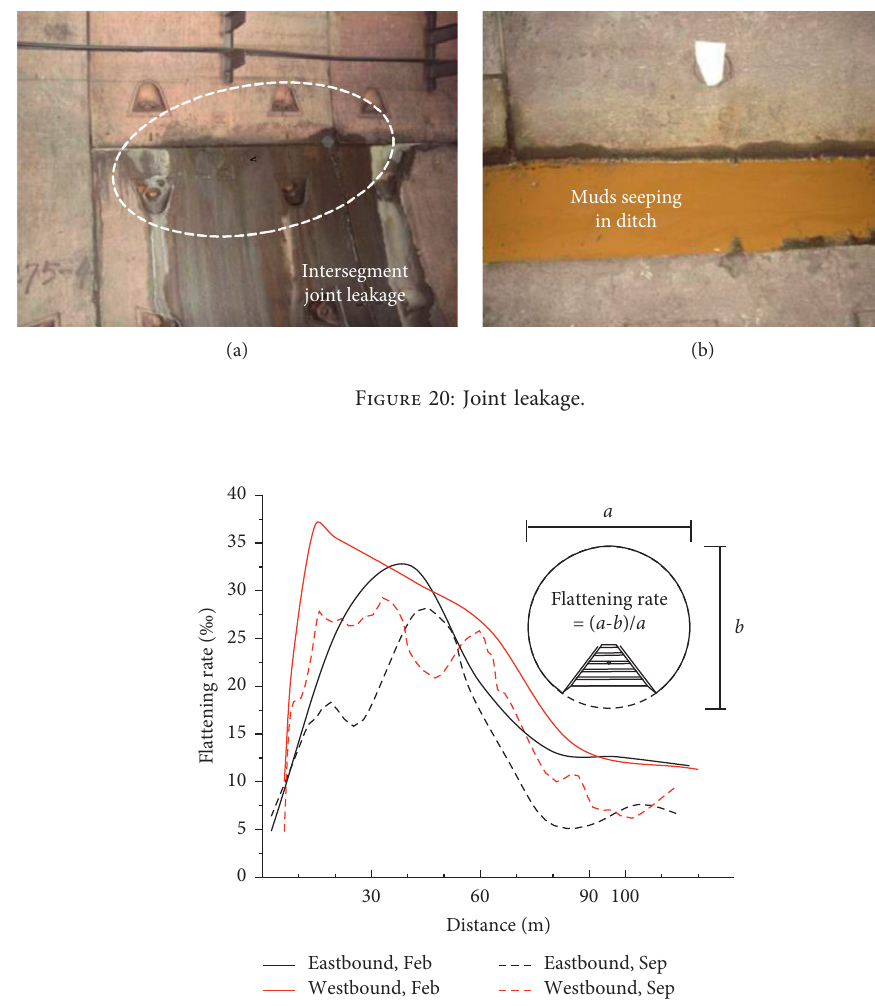
Figure 21: Tunnel flattening rate.